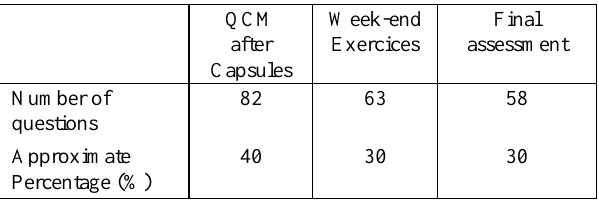
Table 1: Total number of questions for the 3 parts (multiple choice questions, exercises, and the final evaluation).